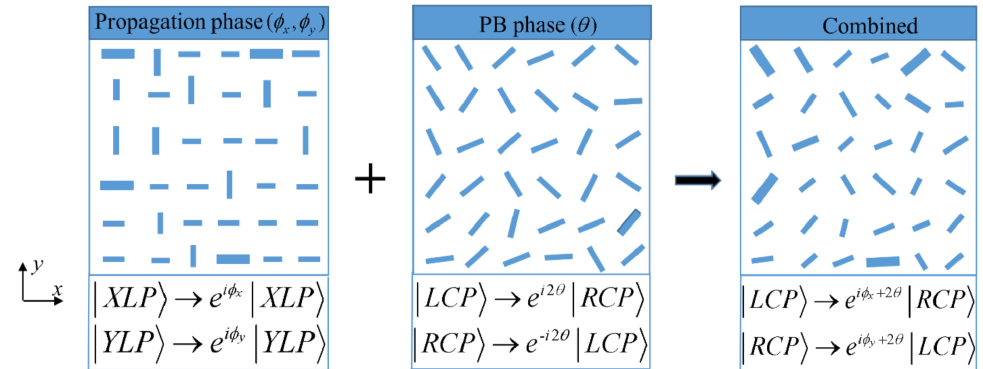
Figure 2. The relationship between propagation, PB, and combined phases. The combined phase is obtained by simultaneously adjusting the propagation phase (only changing the size of meta-atoms) and the PB phase (only changing the rotation angle of